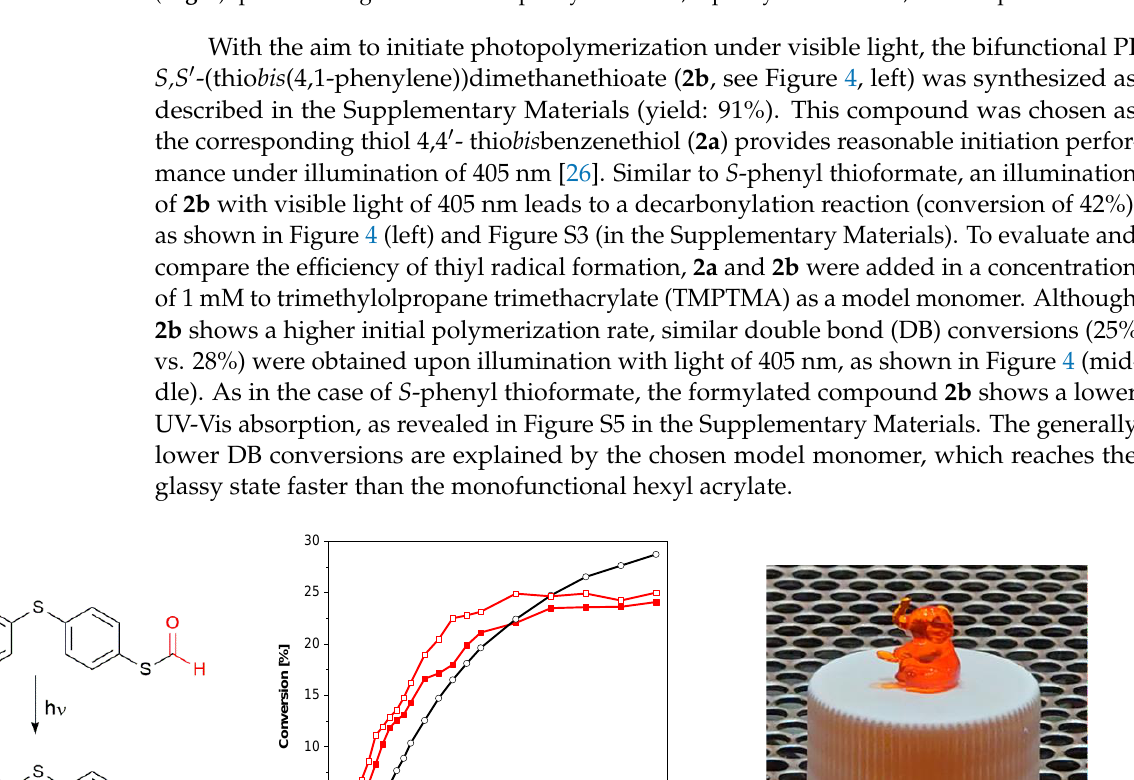
Figure 3. ( Left ): conversion of the hexyl acrylate under UV illumination (185–665 nm, 58.7 mW cm − 2 ). ( Right ): photocleavage reaction of diphenyl disulfide, S-phenyl thioformate, and thiophenol.